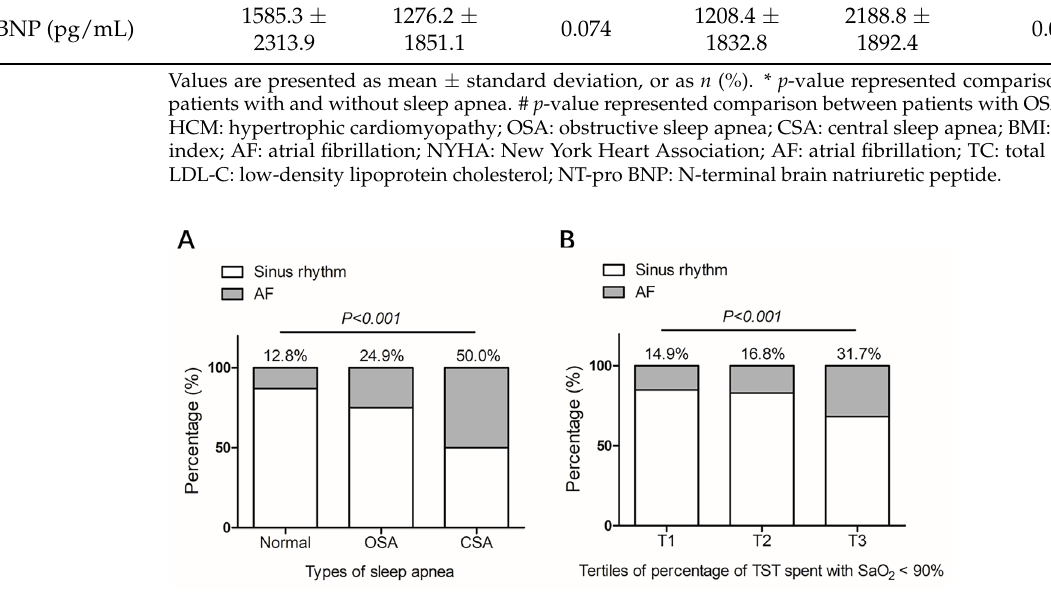
Figure 2. Prevalence of atrial fibrillation in patients with hypertrophic cardiomyopathy grouped by types of sleep apnea ( A ) or severity of nocturnal hypoxemia ( B ). Severity of nocturnal hypoxemia was measured based on percentage of TST spent with SaO 2 < 90%. Tertiles of percentage of TST spent with SaO 2 < 90% were classified as following: T1 (<0.3%), T2 ( ≥ 0.3 to <5.1%) and T3 ( ≥ 5.2%). AF: atrial fibrillation; OSA: obstructive sleep apnea; CSA: central sleep apnea; TST: total sleep time; SaO 2 : oxygen saturation. Table 1. Clinical characteristics of patients with HCM grouped according to types of sleep apnea.